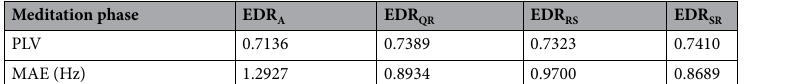
Figure 4. Correlation coefficient and RMSE between simulated constant, ( b ) linear function, and ( c ) sinusoidal function). Meditation